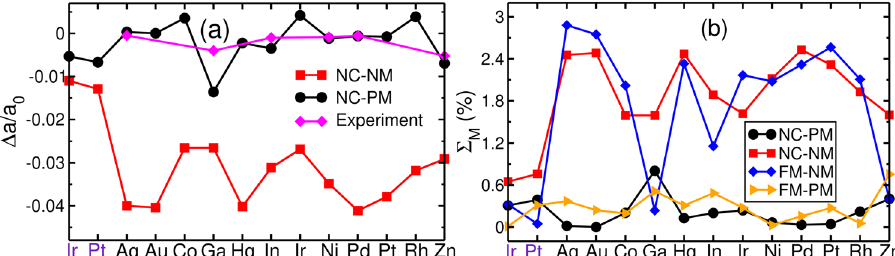
Fig. 3 Negative thermal expansion and barocaloric. a The relative change in the lattice constant ( Δ a/a 0 ) and b the magnetic deformation ∑ M for the Cr 3 X N and Mn 3 XN antiperovskites (X and X are the elements present on the x -axis in violet and black, respectively). The lattice constants of noncollinear, FM, PM, and NM states are used to determine Δ a/a 0 and ∑ M